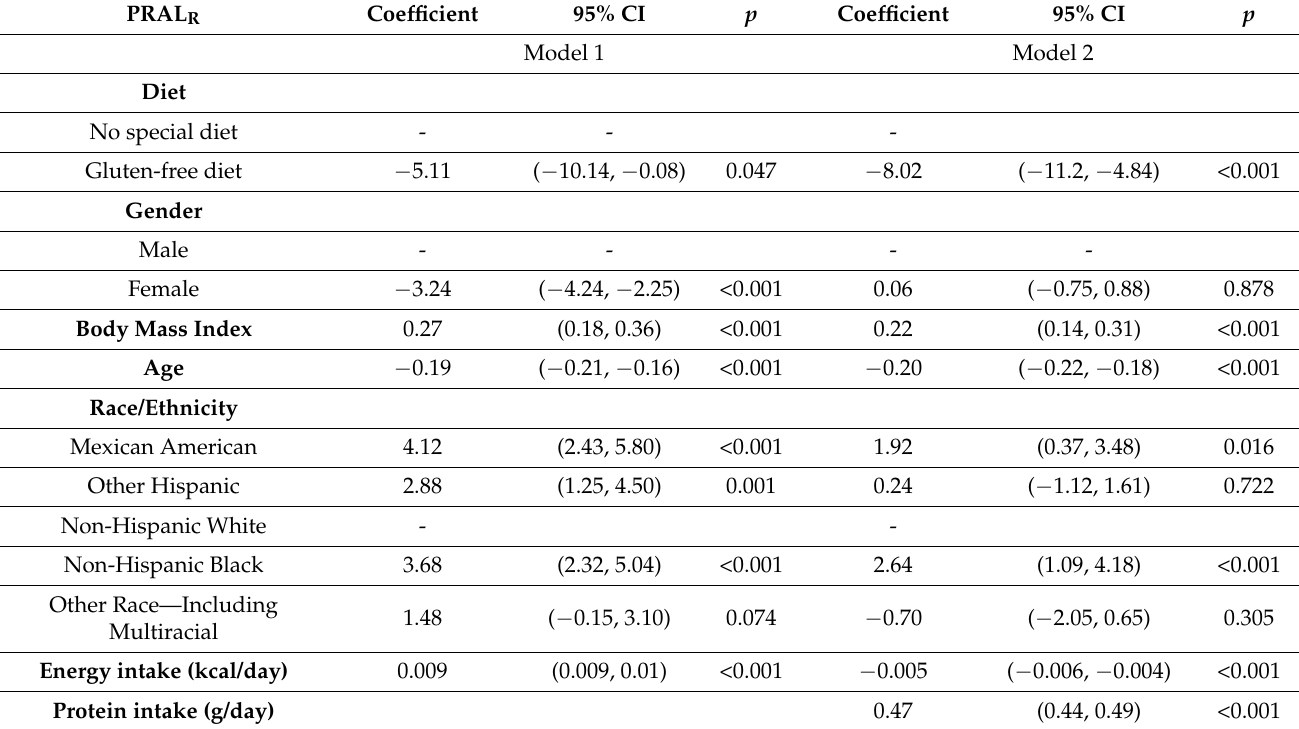
Table 5. Weighted linear regression estimates of predictor variables for outcome variable (PRAL R ): model 1 (left columns) and model 2 (right columns).